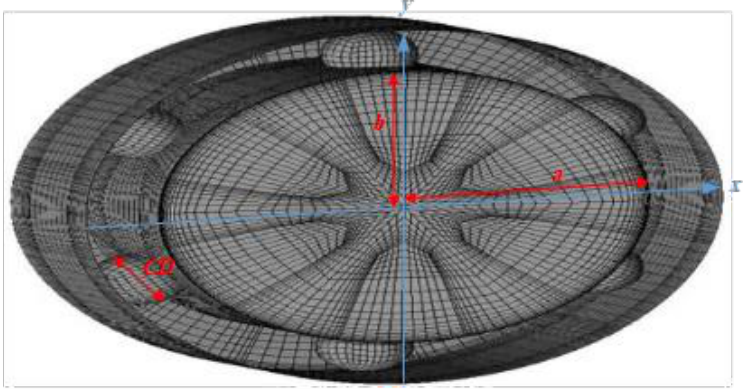
Figure 2. Schematic of computational domain and grid used in the simulations.